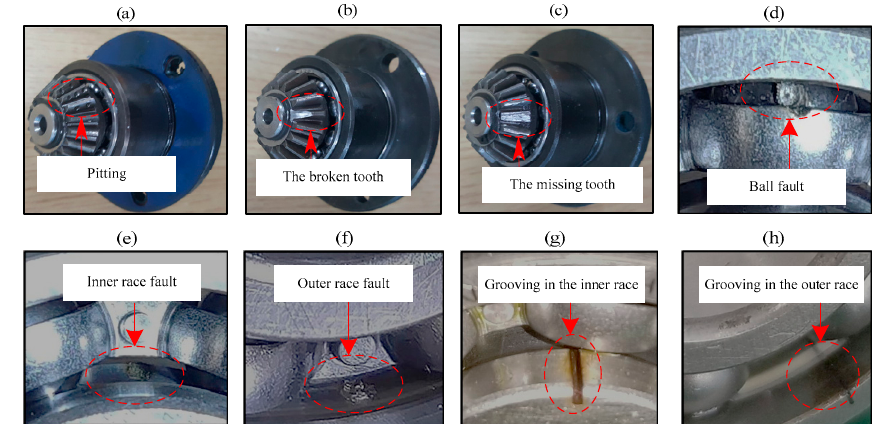
Figure 11. Faulty gears and bearings: ( a ) pitting in the driving tooth, ( b ) broken tooth in the driving tooth, ( c ) missing tooth in the driving tooth, ( d ) ball fault, ( e ) inner race fault, ( f ) outer race fault, ( g ) grooving in the inner race, ( h ) grooving in the outer race.